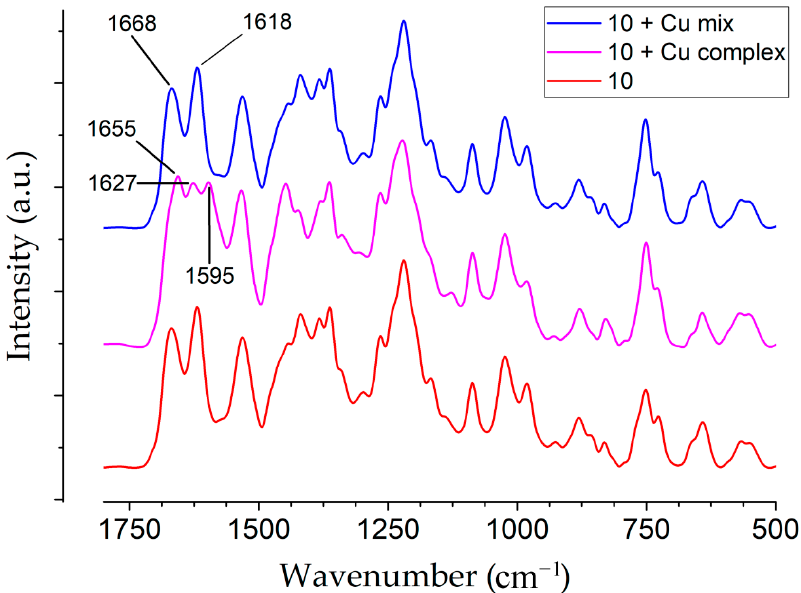
Figure 6. Fragments of FT-IR spectra of compound 10 (red), 10 + Cu mixture (blue), and 10 + Cu complex (purple).